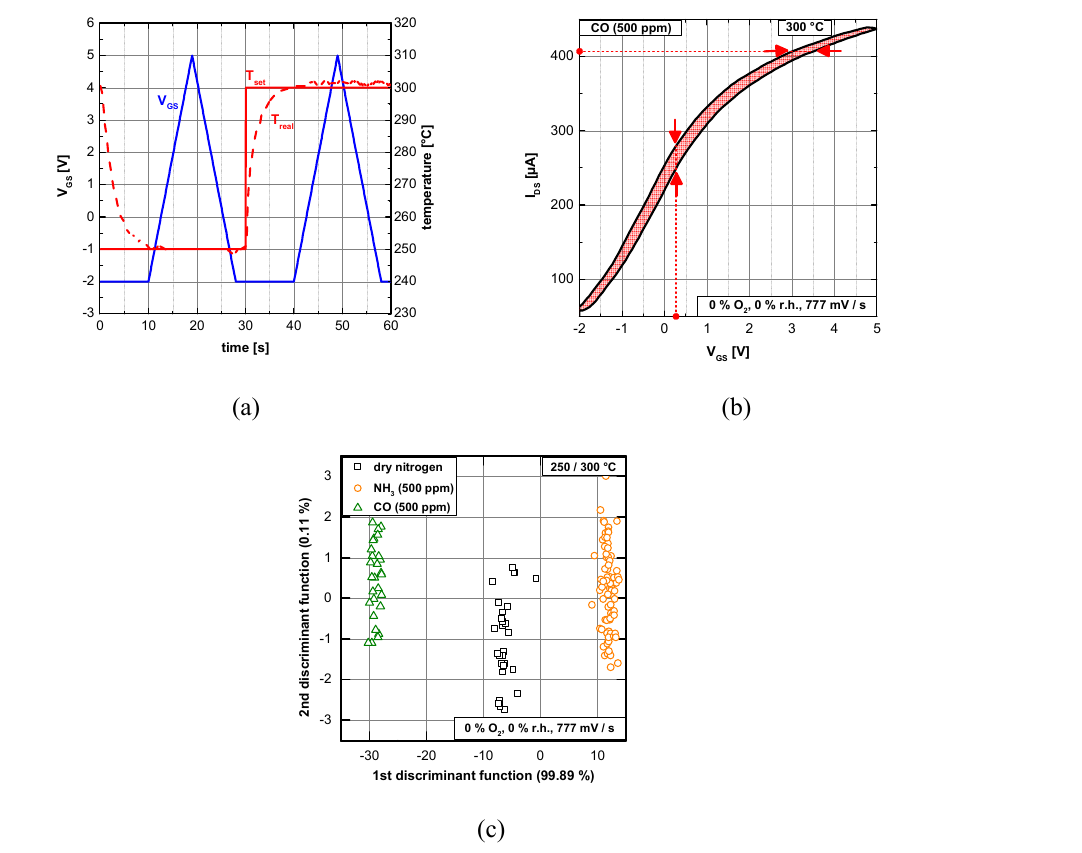
Figure 12. Combined TCO–GBCO cycle (a) . Features that can be extracted from a hysteresis curve: the maximum horizontal and vertical width (red arrows), the position of these maxima (red dots) and the area enclosed by the curve (light red) (b) . LDA discrimination between dry nitrogen (background), CO and ammonia based on hysteresis features (horizontal and vertical width and area) from 9s ramps (from − 2V to 5V, i.e., 777mVs − 1 ) at 250 ◦ C and 300 ◦ C plus the signal mean value over the interval of 0–10s of the cycle (c).